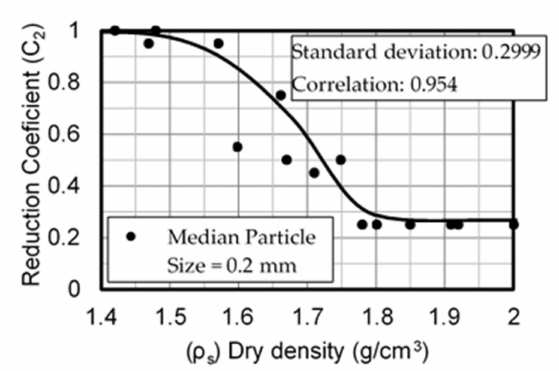
Figure 7. Influence of dry density to the bed-load reduction coefficient (the median grain size and the uniformity coefficient are 0.2 mm and